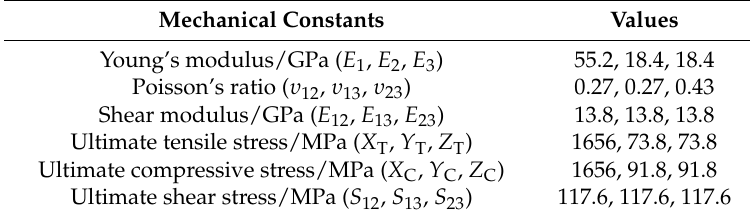
Table 1. The material parameters of unidirectional glass fiber/epoxy composite laminates.